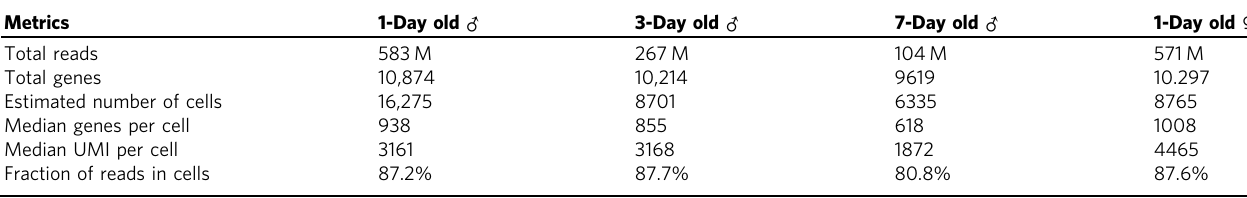
Table 1 Quality control metrics for adult eye scRNA-seq data sets. Metrics